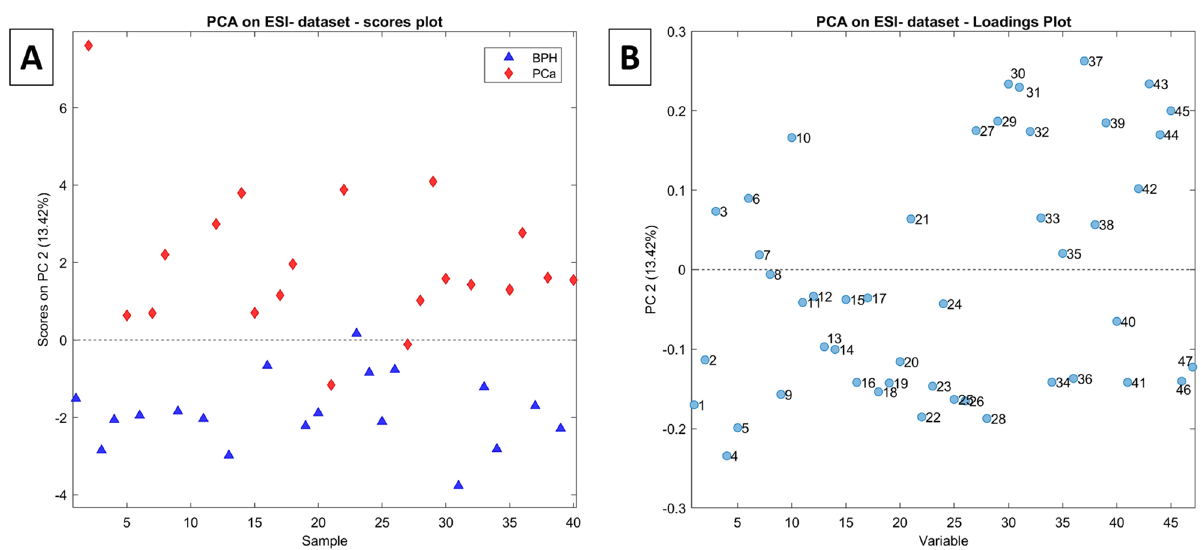
Figure 4. ( A ) scores plot and ( B ) loadings plot of the PCA model for the autoscaled ESI– dataset. The loadings labels are reported in Table 2 (ID